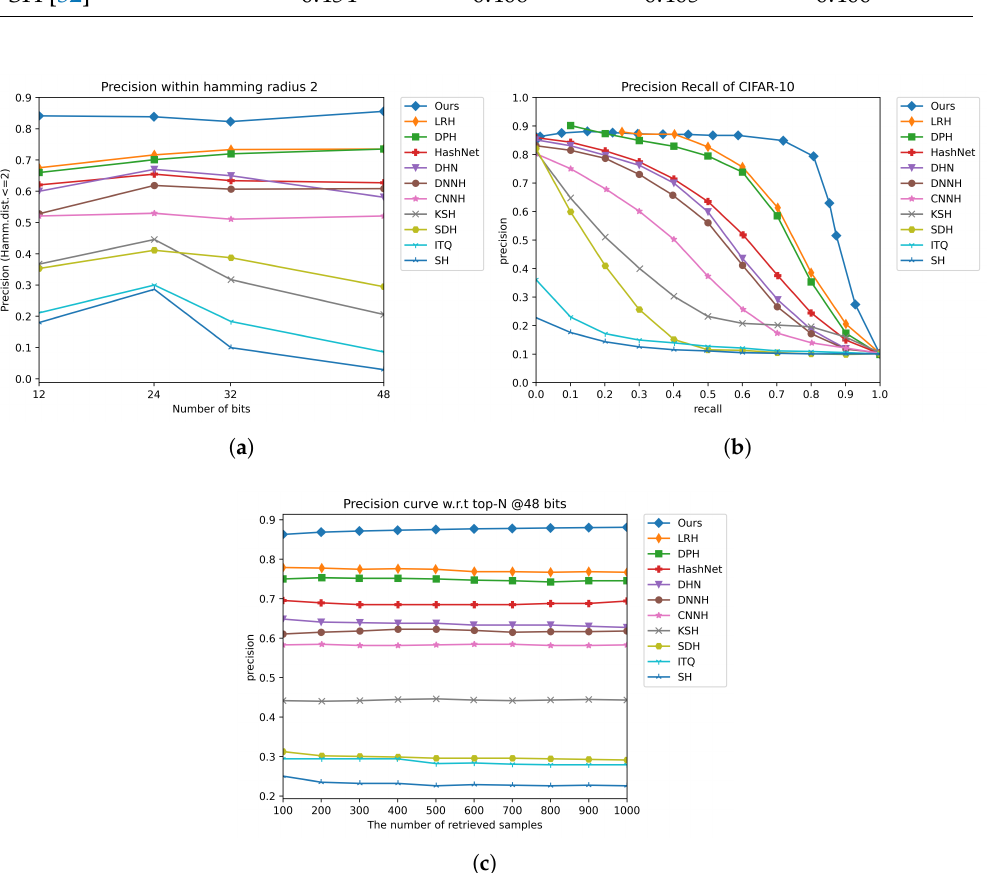
Figure 2. The comparison results on the CIFAR-10 dataset under three evaluation metrics. ( a ) Precision within hamming radius 2. ( b ) Precision recall curve on 48 bits. ( c ) Precision curve w.r.t top-N @48